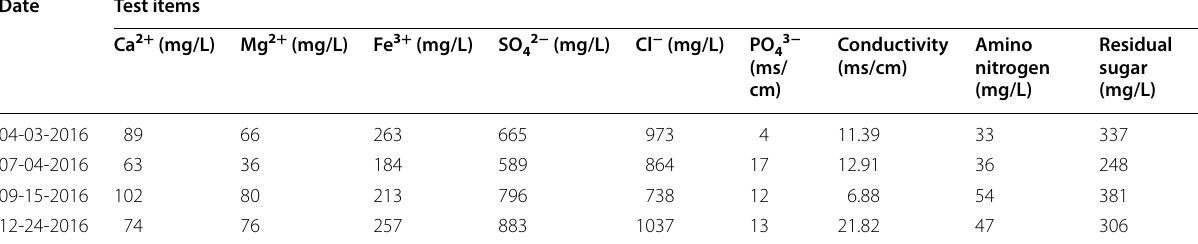
Table 1 Test results for Ion-exchange wastewater from 4 different sample